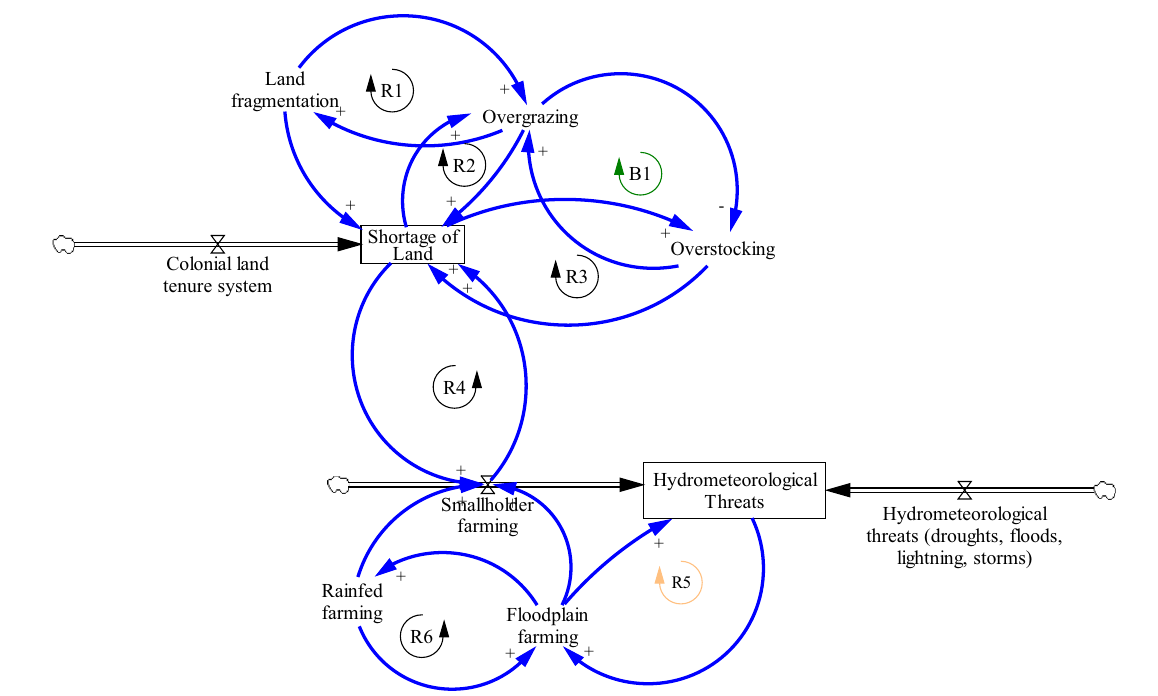
Fig. 2 Interaction of variables underlying vulnerability to hydrometeorological threats in the northern semiarid tropics (SAT), Zimbabwe (R— reinforcing;